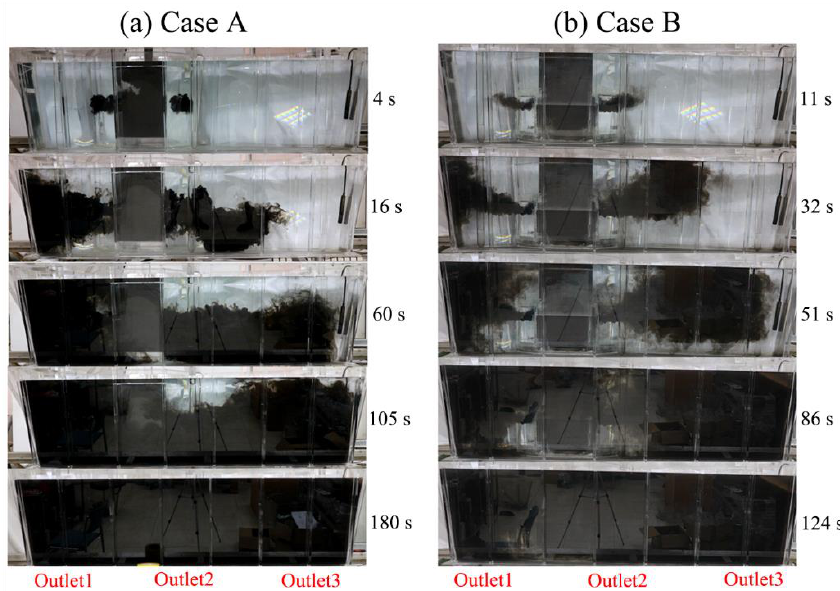
Figure 4. Ink trajectory comparison of cases A ( a ) and B ( b ).